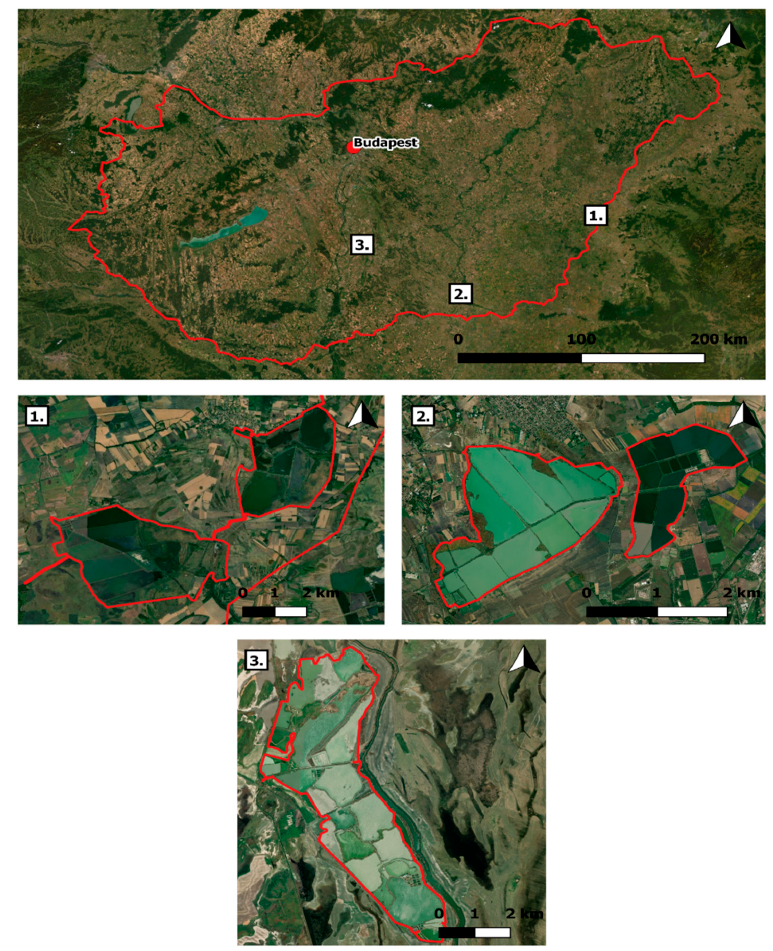
Figure 1. Selected fishpond systems and their location in Hungary: 1. Biharugra fishpond system; 2. Fehértó of Szeged; 3. Akasztó fishpond system (created with QGIS 2.18.10 (Open Source Geospatial Foundation, Chicago, IL, USA)).